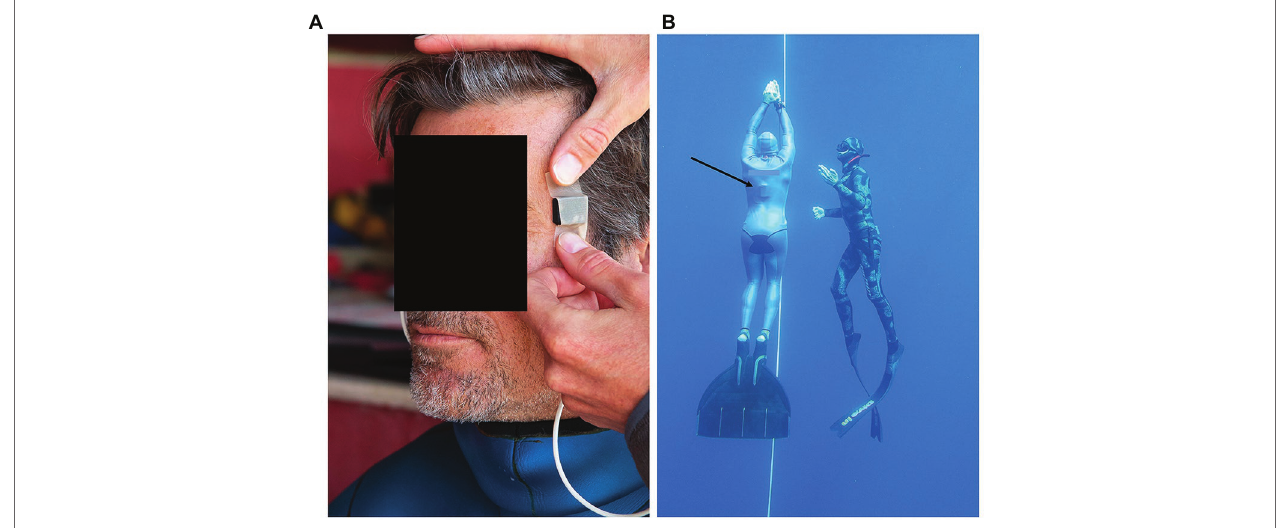
FIGURE 1 | (A) Sensor heads of the pulse oximeter probes were applied to the temple and fixated with medical tape, and thereafter by pressure from the hood of the wetsuit, (B) freedivers performed their training dives from a buoy and dove to their predetermined depth along a vertical line, and were accompanied up by a safety diver. Black arrow points at the recording unit of the pulse oximeter located underneath the